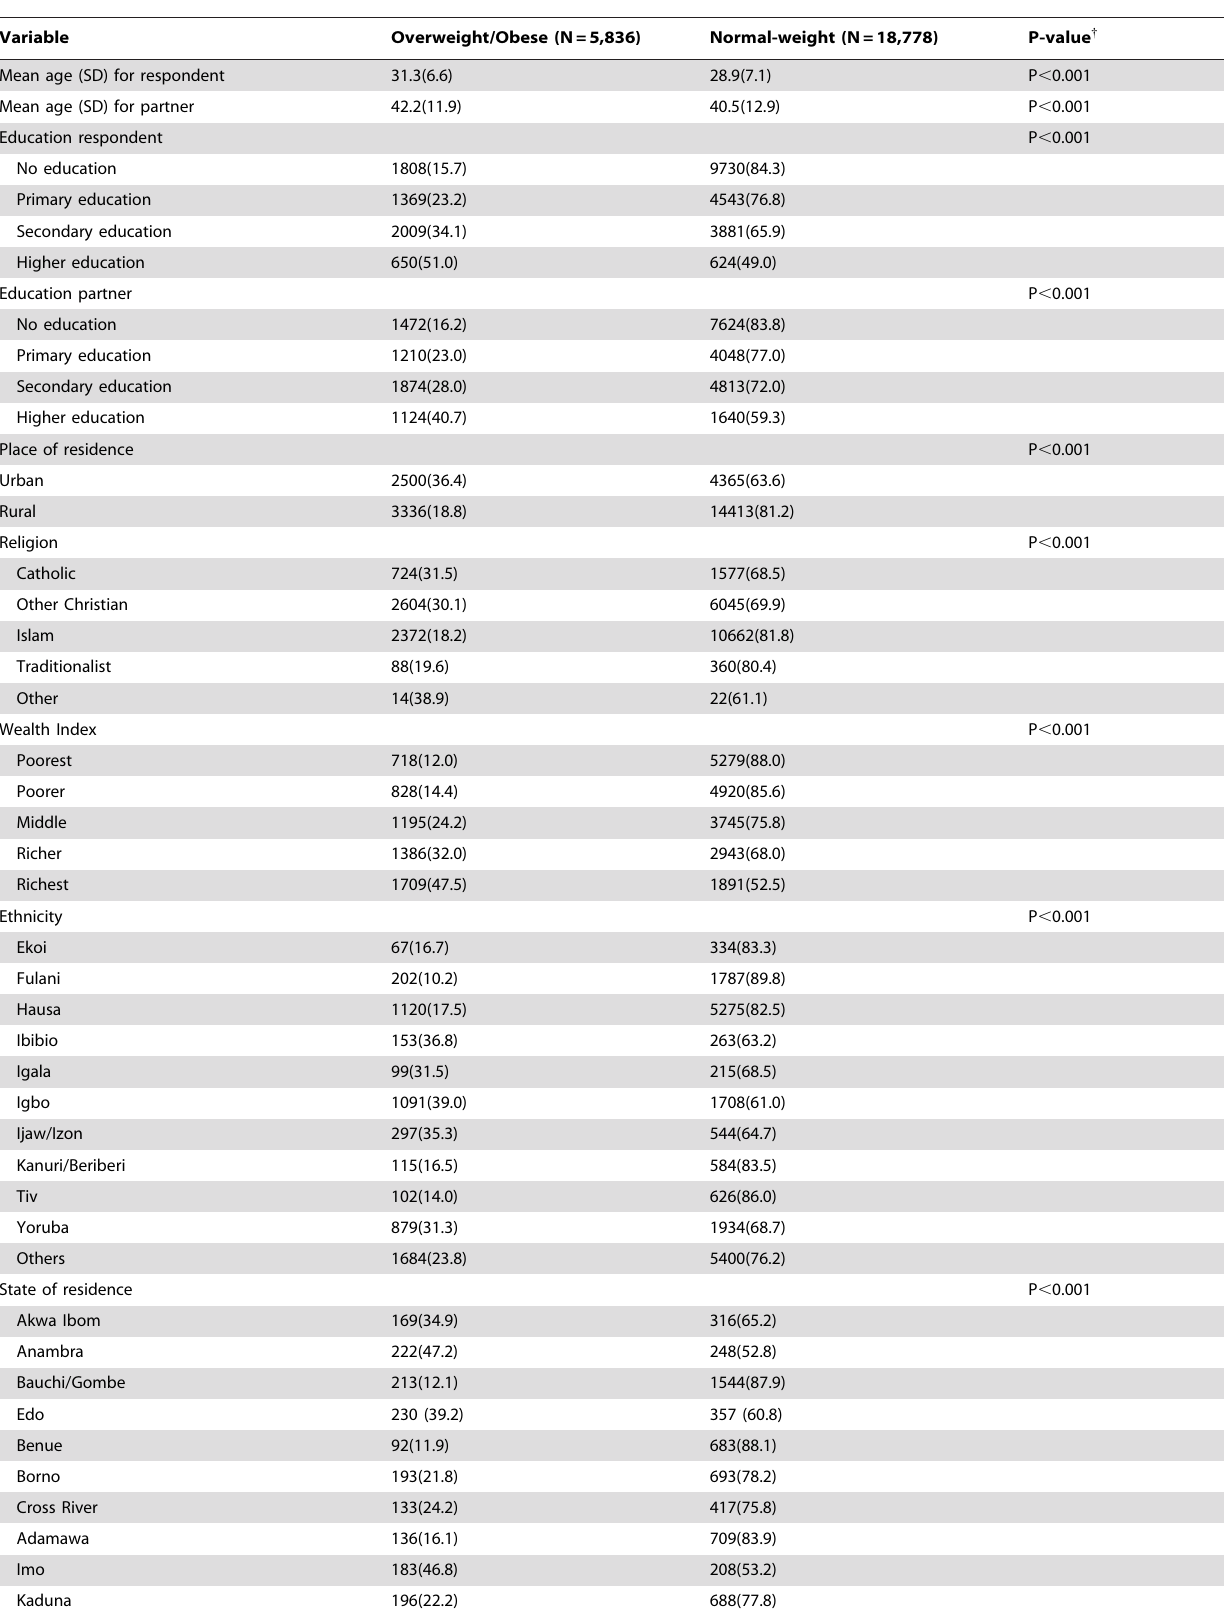
Table 2. Baseline characteristics of the study population by overweight/obesity status (NDHS